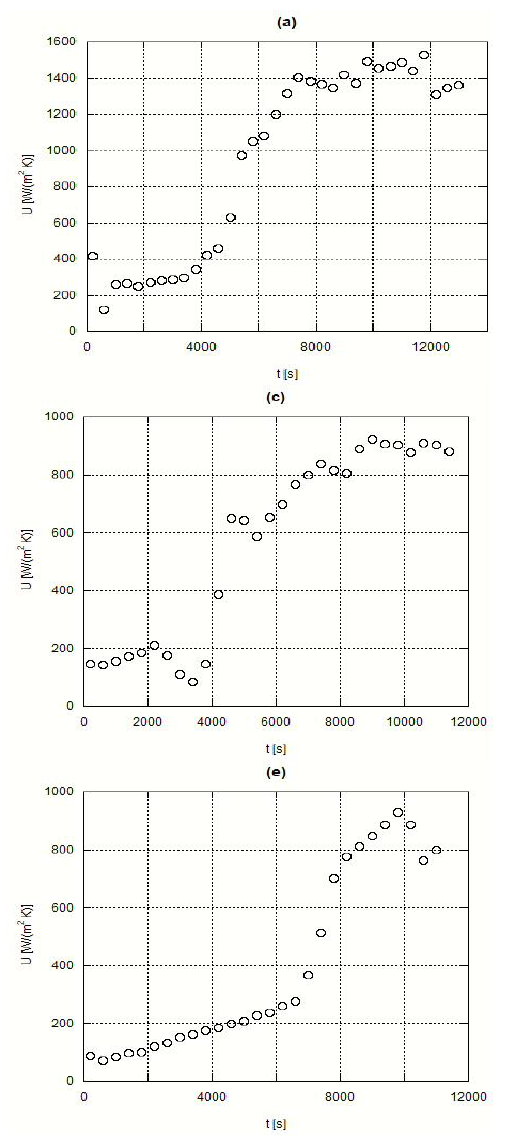
Figure 9. Evolution of the overall conductance U for A82. Left column fusion process; Right column, solidification process. Plots ( a , b )—t1 test conditions; Plots ( c , d )—t2 test conditions; Plots ( e , f )—t3 test conditions.